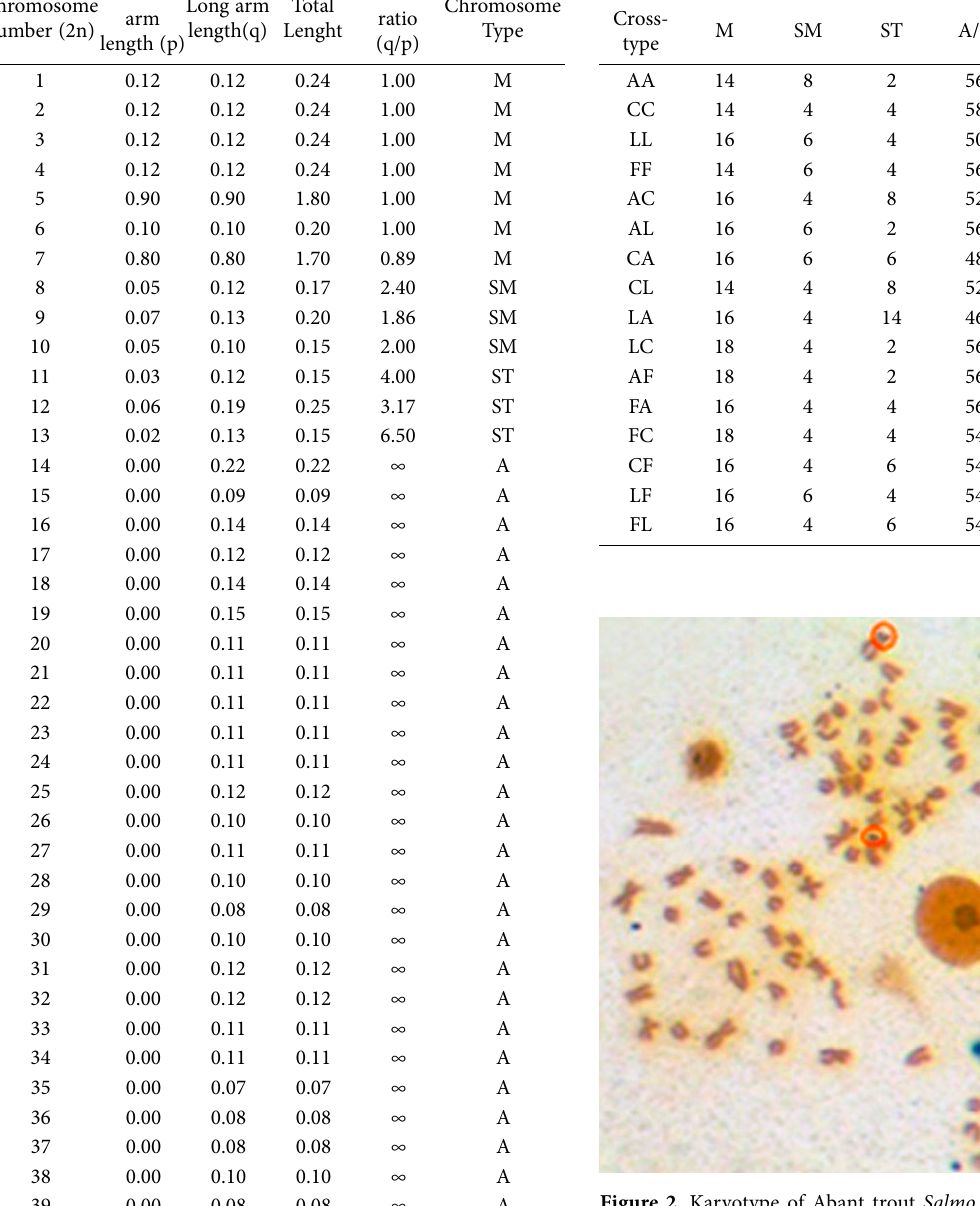
Figure 2. Karyotype of Abant trout Salmo t. abanticus with silver staining. Presence of NOR sites on the short arm of the submeta- centric chromosome indicated with red